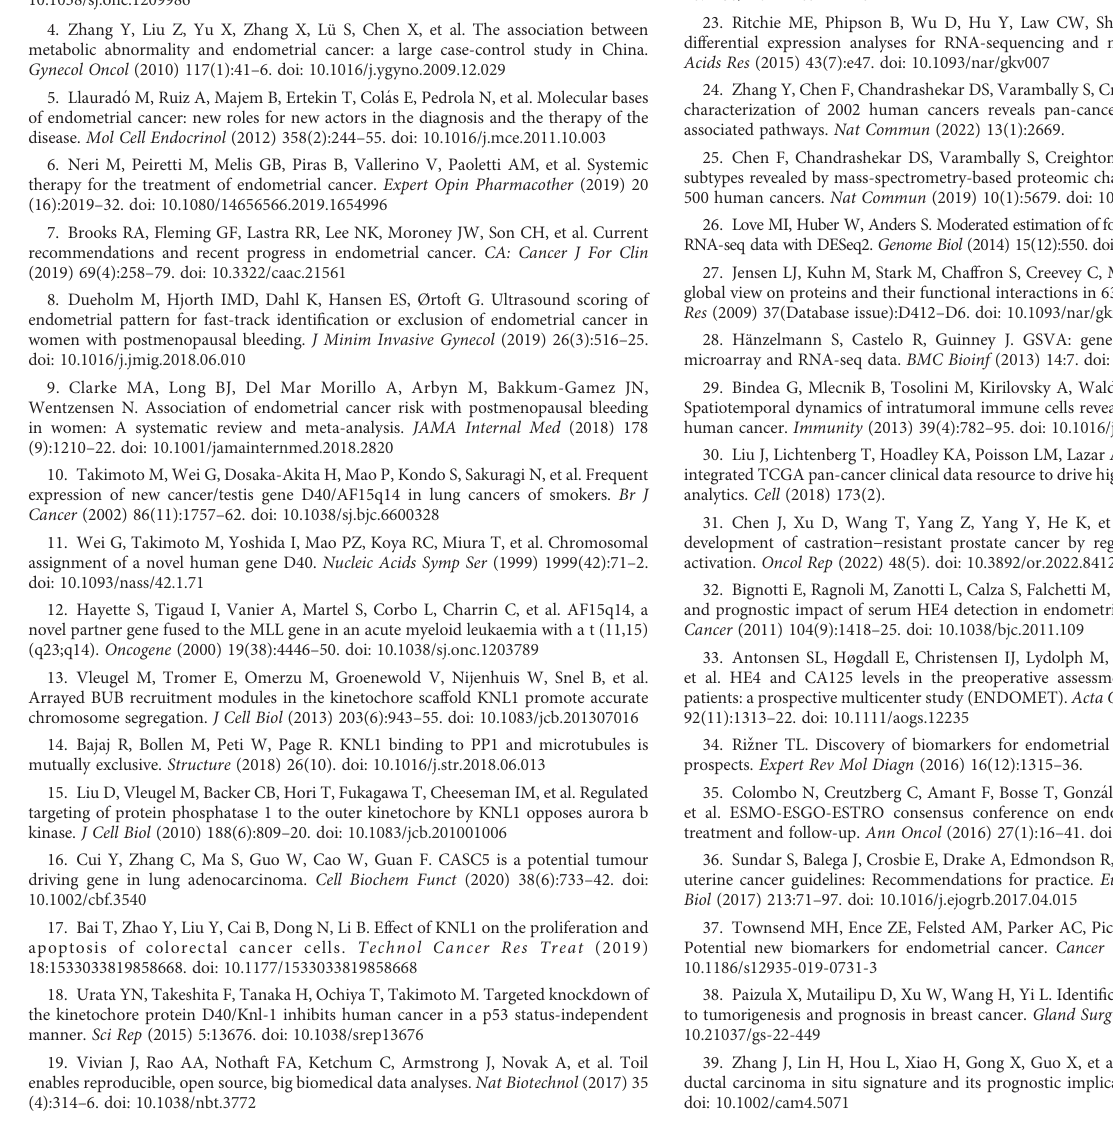
SUPPLEMENTARY FIGURE 2 Expression of KNL1 in UCEC patients with different histological types. (A) Box diagram ofKNL1 expression obtainedfromRNA-seq datainthe TCGAdatabase. (B) Box plot of KNL1 expression using immunohistochemical analysis of 108 clinical samples.